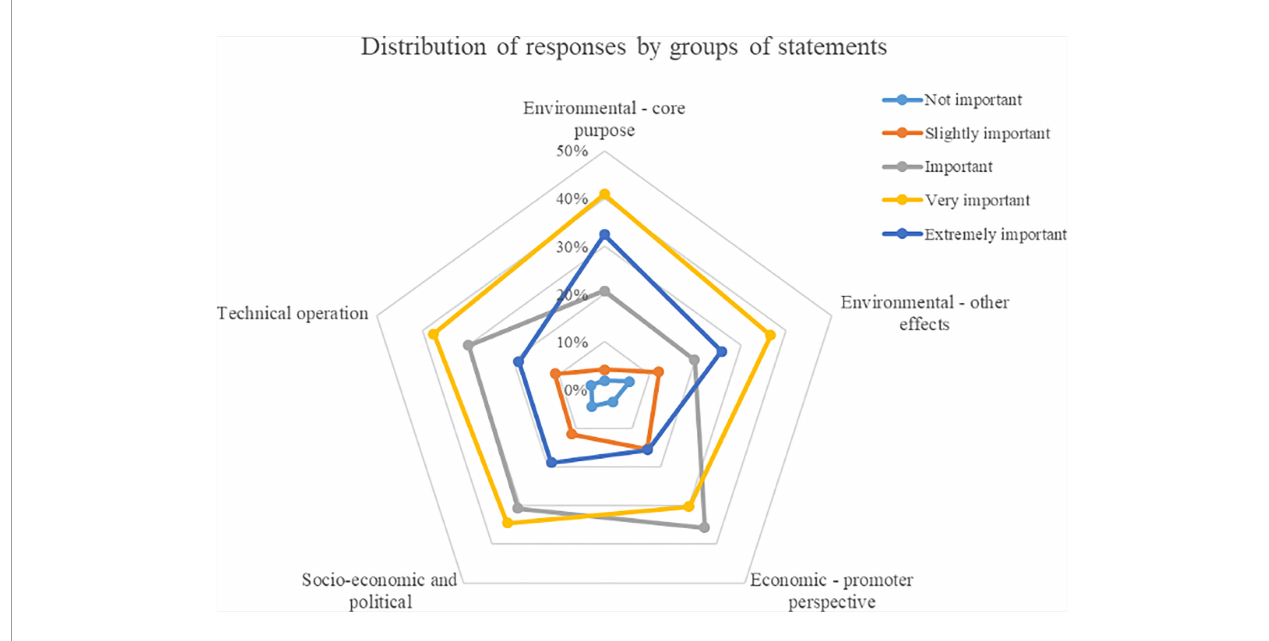
FIGURE 6 | Distribution of the responses according to the groups of statements.